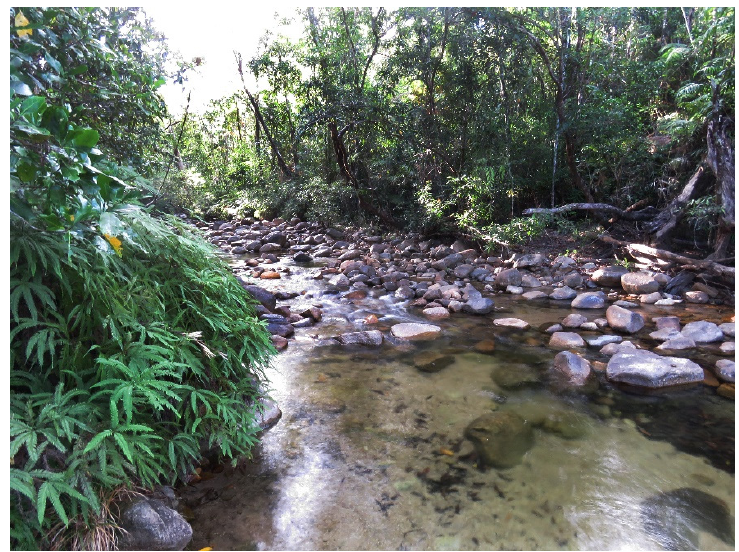
Figure 8. Maintaining a positive outlook: A stream in a forest to show a place that reminds of fam- ily